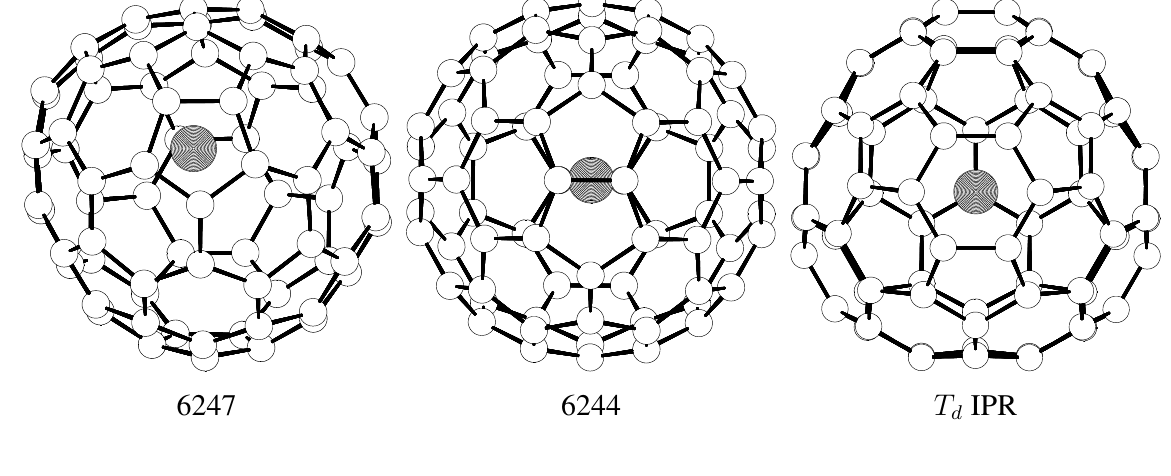
Figure 5. B3LYP/3-21G (cid:24) dz optimized structures of the three most populated La@C 76